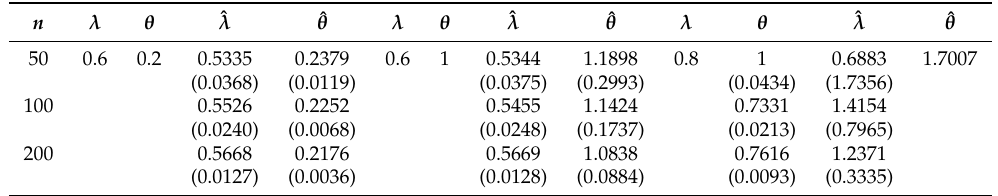
Table 2. Empirical means and the MSEs of the maximum-likelihood estimates of the LiE2 for different values of the